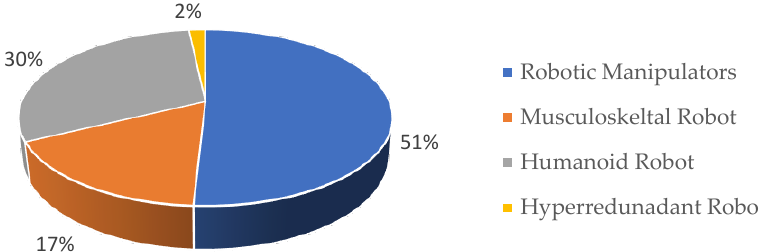
Figure 2. Percentage of papers describing the different robotic systems.